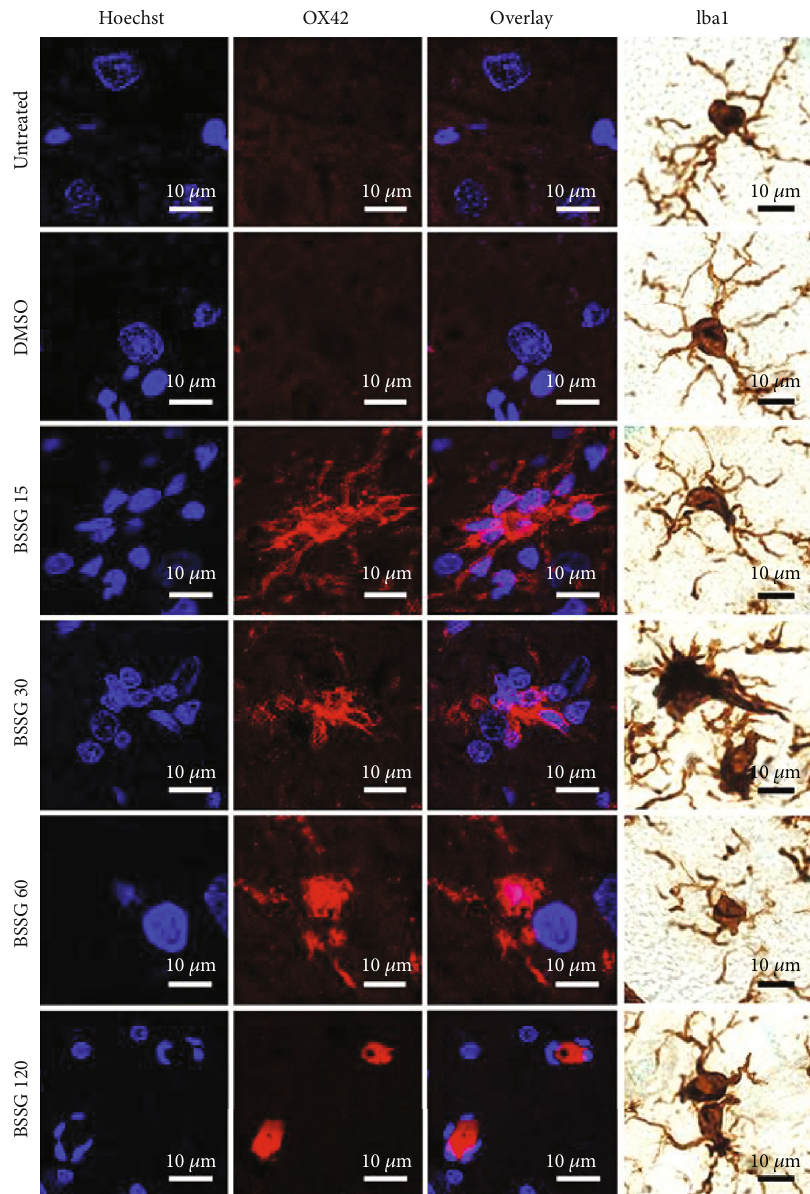
Figure 3: Changes in the cell form during activation of microglia in the SNpc after BSSG administration. Representative confocal micrographs of OX42(+) and Iba1(+) cells in the SNpc of untreated and DMSO mock control rats and of rats at di ff erent days post-BSSG injection (shown at the left side of the